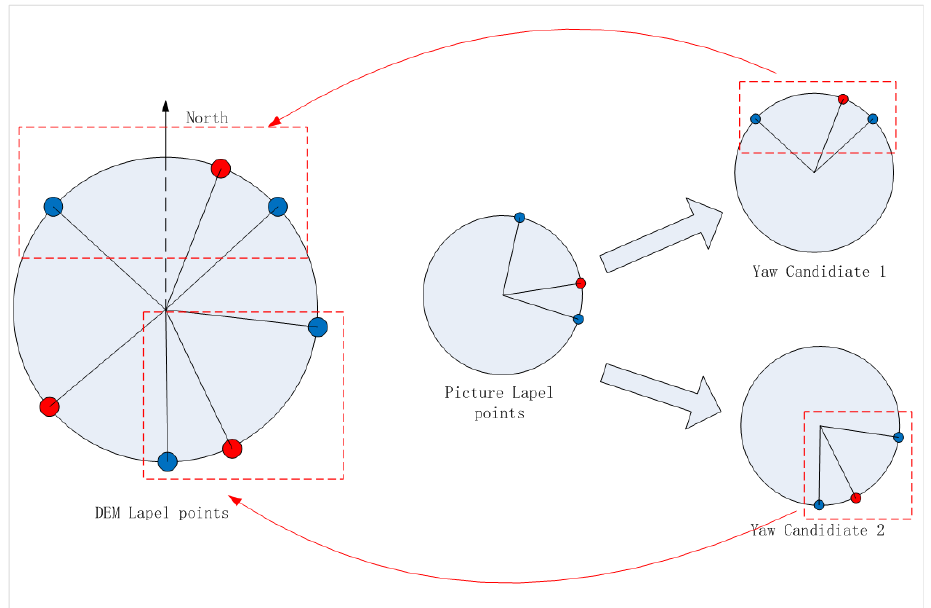
Figure 24. For the same DEM skyline (enclosed in larger dotted red rectangles), the coarse matching of the image skyline may have multiple yaw candidates (enclosed in the smaller dotted red